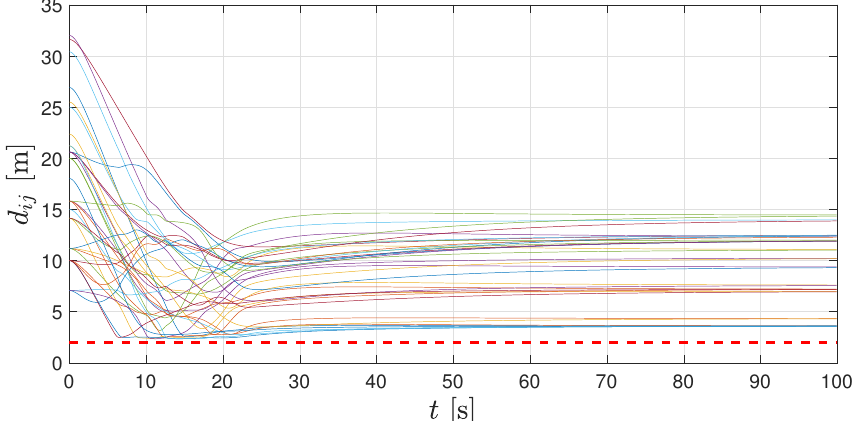
Figure 6. Distancesbetween any pair of agents from 0 [s] to 100 [s]. The dashed line indicates the minimum allowed distance.